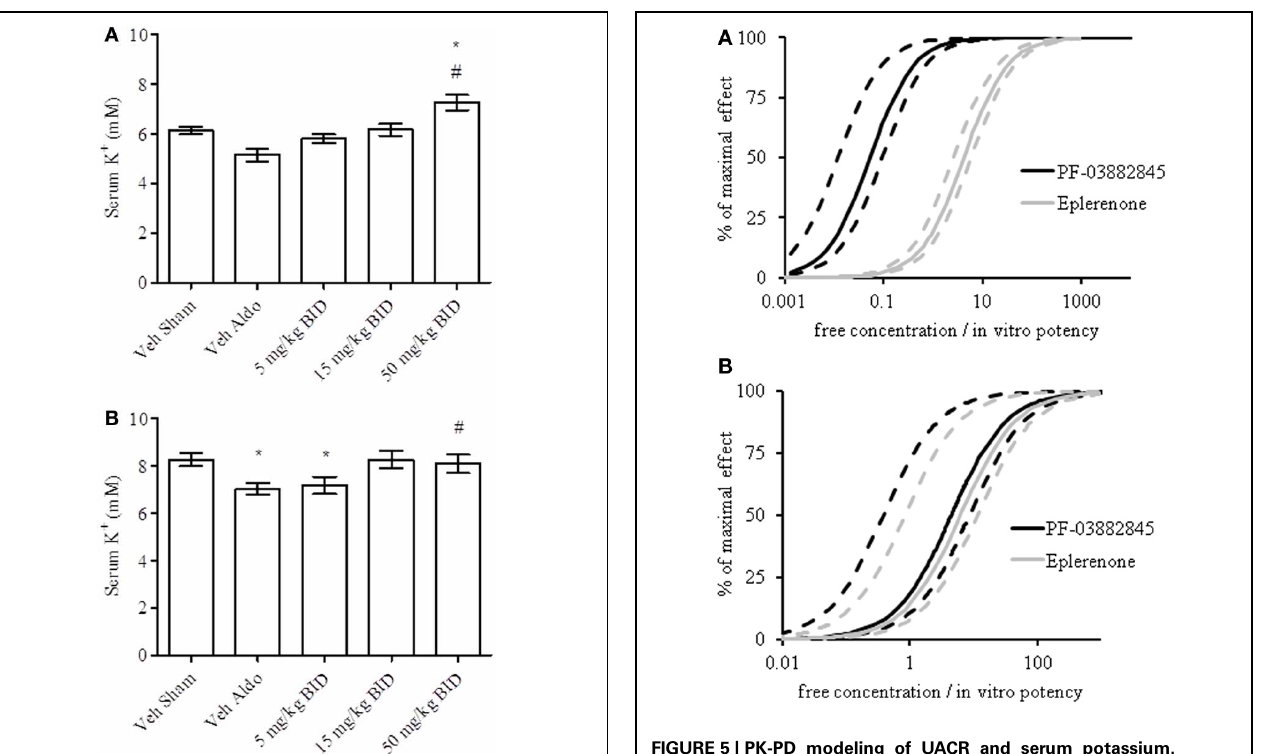
FIGURE 5 | PK-PD modeling of UACR and serum potassium. Concentration-effect curves of eplerenone (gray lines) and PF-03882845 (black lines) for UACR (A) and serum K + (B) following 27 days of treatment. Dashed lines indicate the 95% upper and lower confidence intervals. Data were modeled using an indirect response model. A double delta equation was used to express the pharmacodynamic response for serum K +